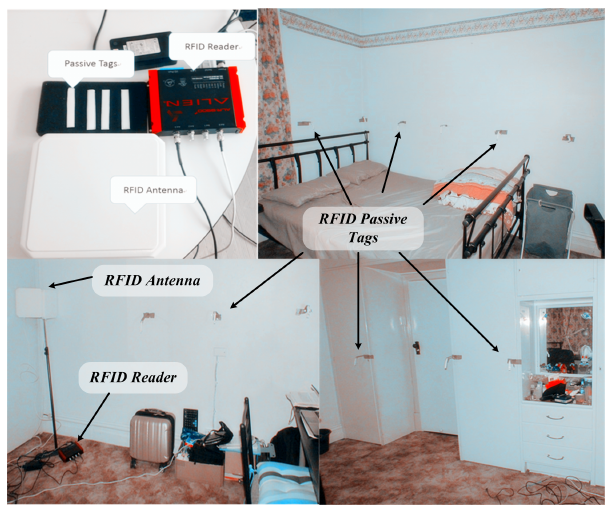
Figure 2: Hardware